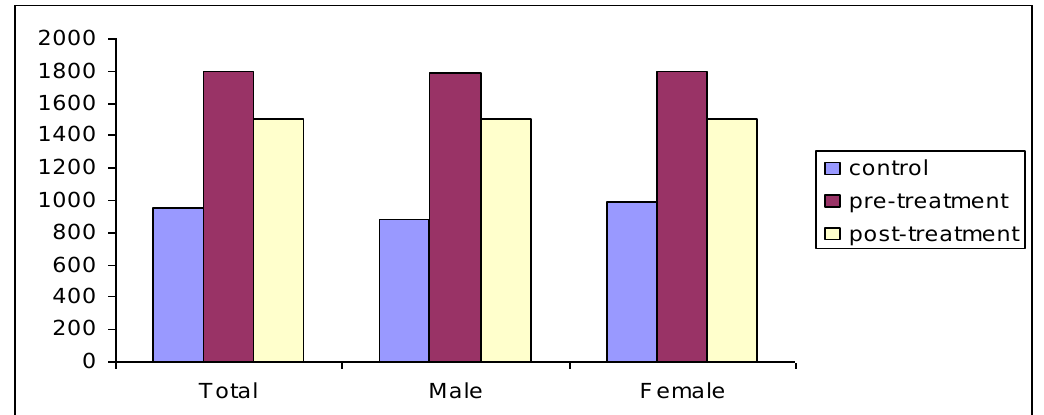
Figure (2): The level of serum complement three at baseline and one month later of using chloroquine phosphate.